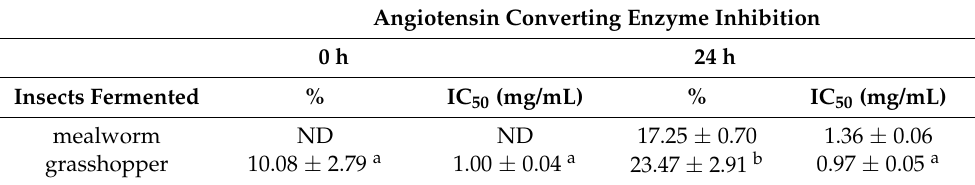
Table 5. Values of ACEI activity for samples fermented by L. lactis NRRLB-50572.